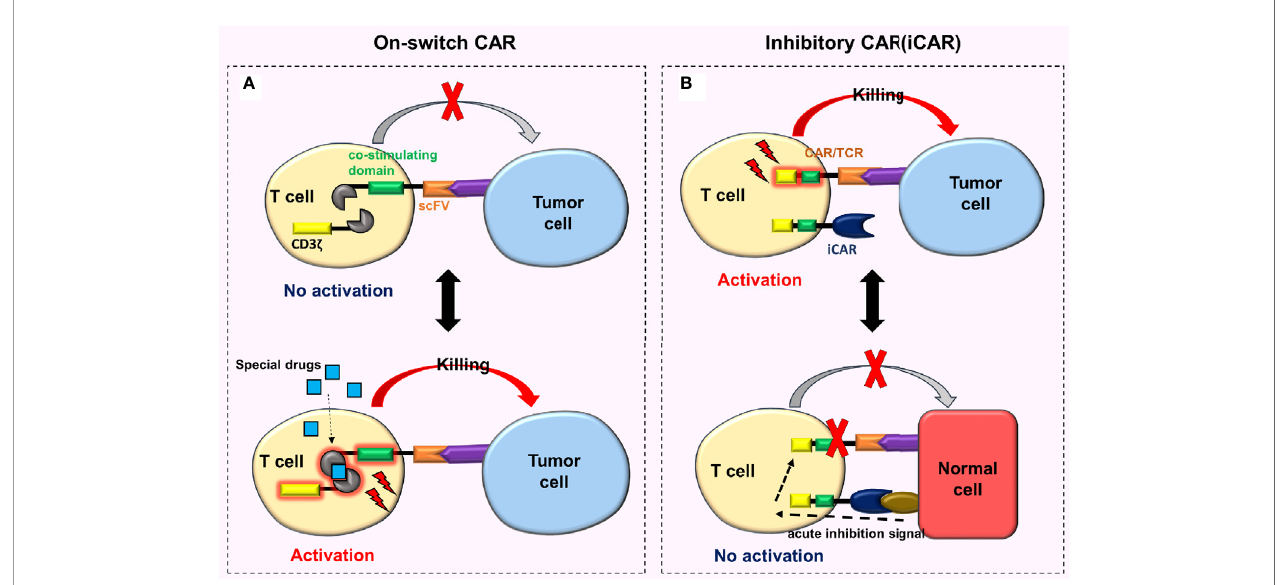
FIGURE 6 | On-switch CAR and iCAR. (A) The on-switch CAR-T cells are initially turned off, activated only with specially designed drugs, then recognize, bind to, and kill the targeted tumor cells. When the drugs are not present, the CAR-T cells return to their off state; (B) When iCAR-T cells bind to the corresponding tumor cells, iCAR-T cells are activated and kill the tumor cells. Nonetheless, when iCAR-T cells combine with normal cells, the iCARs produce inhibitory signals which prevent traditional CARs or TCRs from functioning, thus the normal cells remain